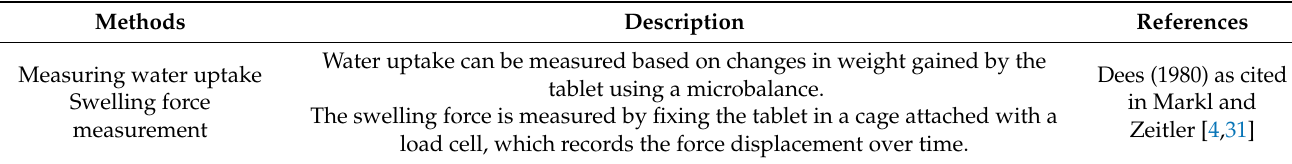
Table 1. Methods used to quantify compact disintegration